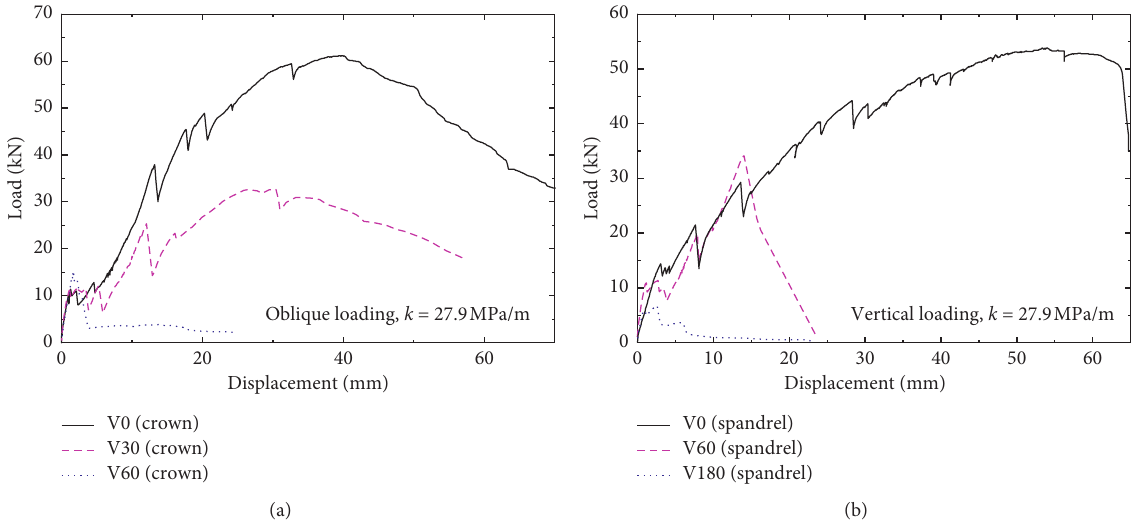
Figure 6: Load-displacement curves of the lining with void defects: (a) crown and (b) spandrel.